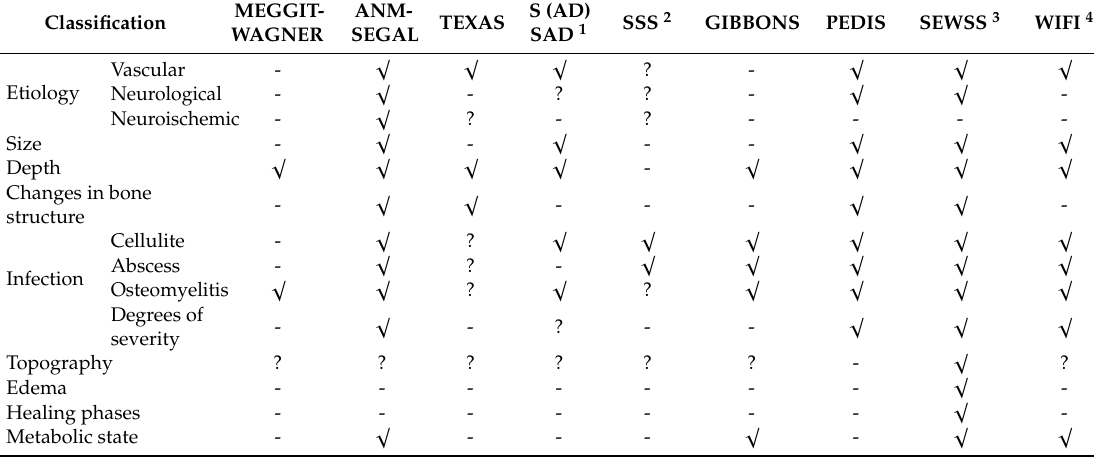
Table 1. Classifications of diabetic feet. Comparison of clinical variables according to the criteria recommended by the American Diabetes Association (in terms of management standards, etiology, size, and depth, as well as damage to the deep neighboring structures, degree of infection, evaluation of the vascular and nervous system, and systemic involvement)